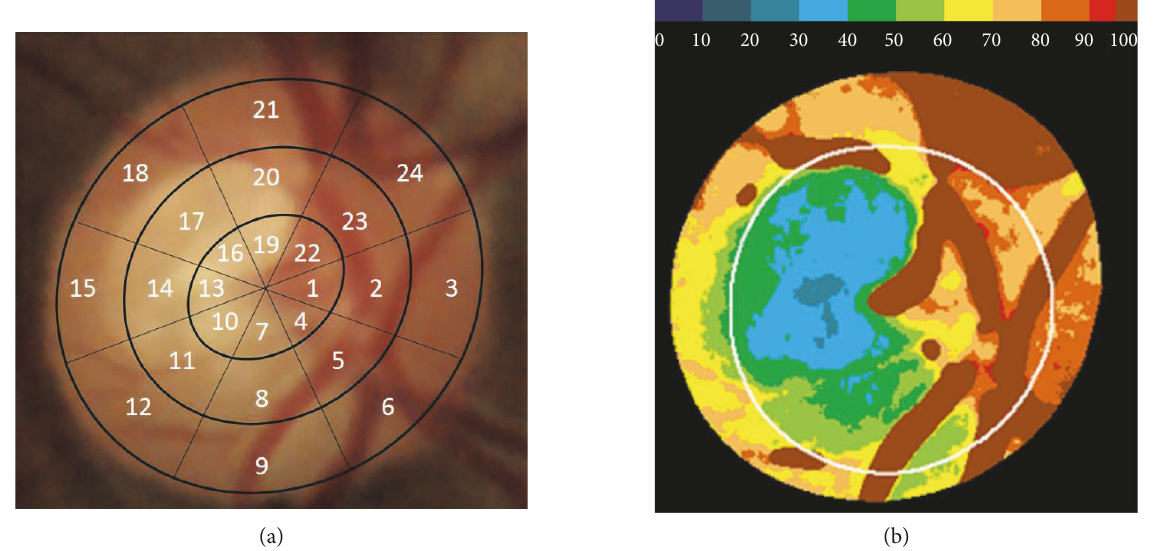
Figure 1: (a) A photographic image of the optic nerve head, divided into 24 regular sectors around its centroid, used by the Laguna ONhE program (3 nasal and 15 temporal). (b) The relative percentage amounts of hemoglobin in the optic nerve head tissue compared to that of the vessels, which is taken as the reference value (100%) and the estimated position of the